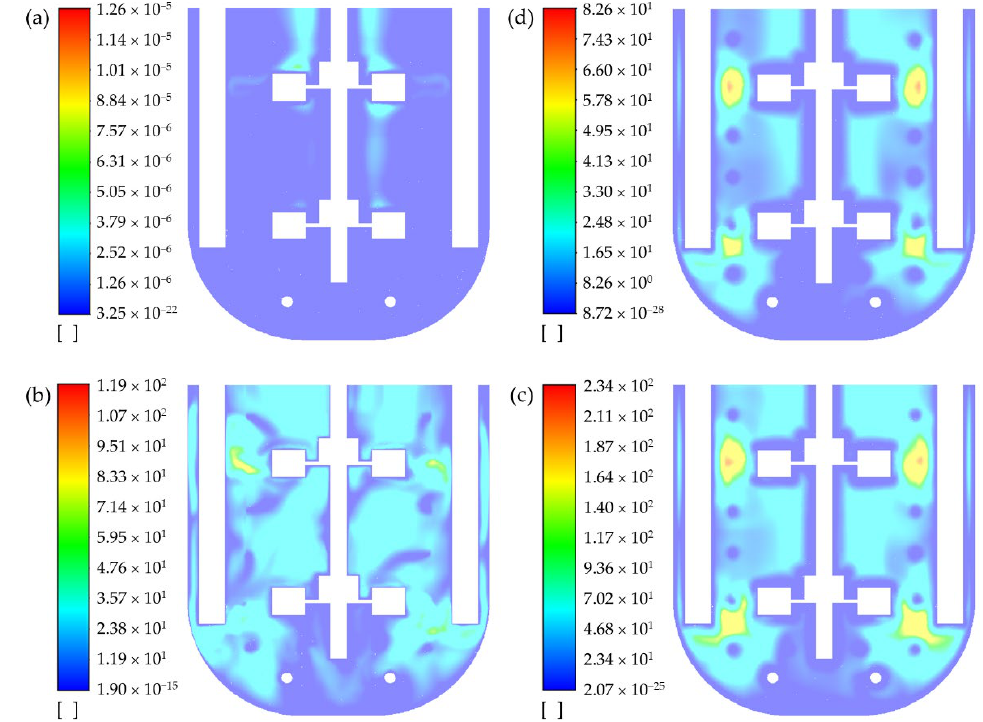
Figure A11. Contours of instantaneous turbulent viscosity ratio, at plane YZ, simulated for the batch abiotic systems with non-Newtonian fluids. ( a ) Xanthan Sol C, after 10 impeller turns with standard k-omega; ( b ) XSolB- SSTkω, after 58 impeller turns; ( c ) XSolB- kklω, after 58 impeller turns; and ( d ) XSolA- kklω, after 58 impeller turns.